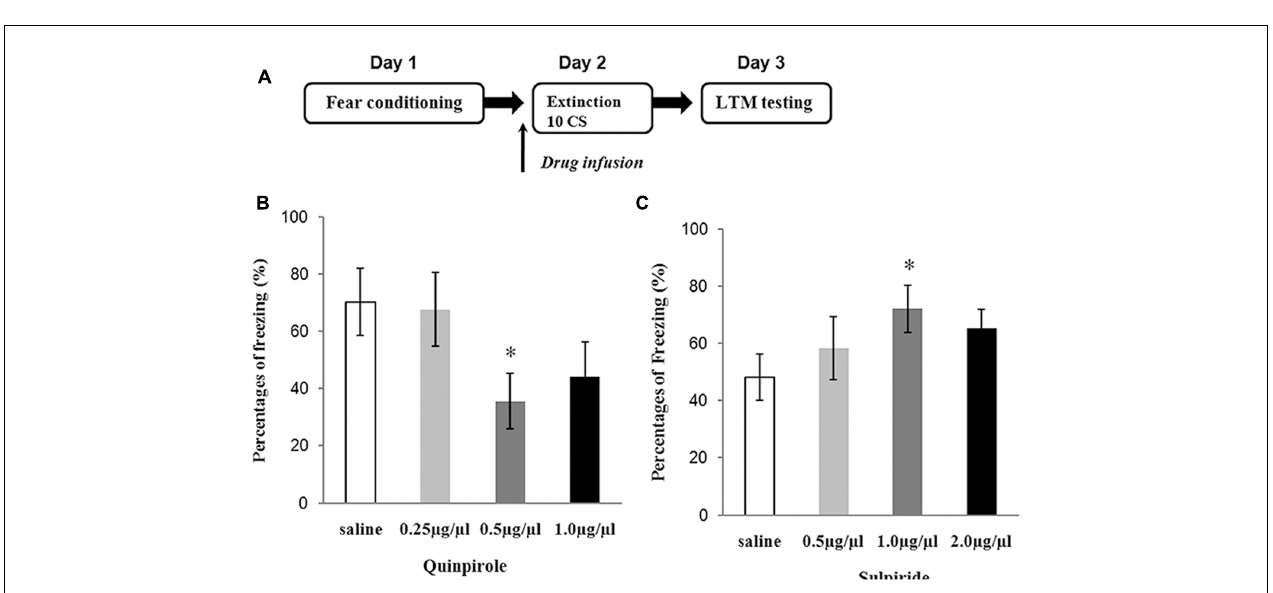
FIGURE 1 | The location of the amygdala basolateral amygdala (BLA). Placement of the injection cannulae at the end of each experiment in rats administered intra-BLA injections of each drug and saline. (A) The injection sites are indicated by black dots. (B) The diagram shows a coronal view of the rat brain at 2.8 mm posterior to the bregma.